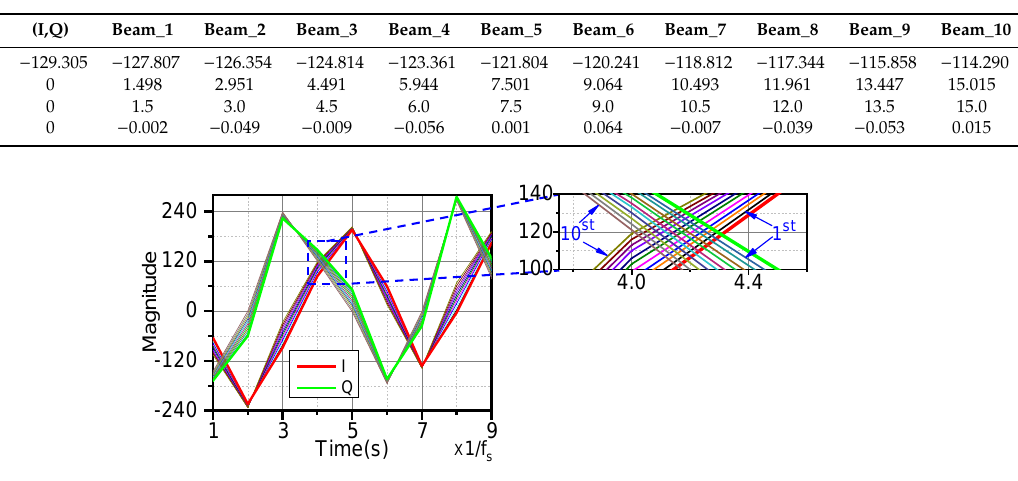
ff ects of the phase shift showing the partial amplification of delay Figure 10. The effects of the phase shift showing the partial amplification of delay beams. Figure 10. The e